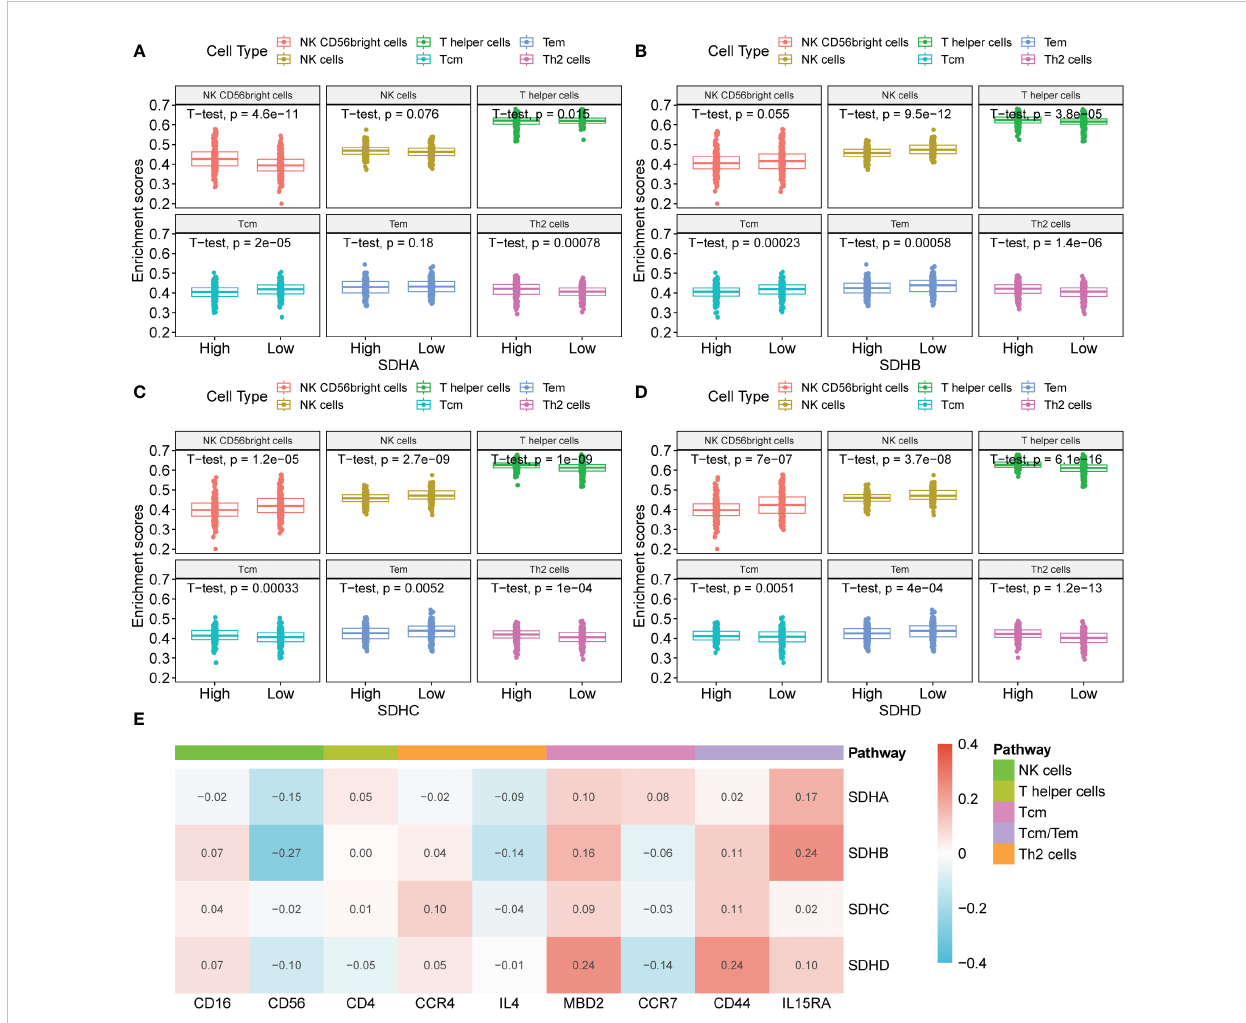
FIGURE 6 Association between SDHs and immune in fi ltration. (A-D) The ssGSEA analysis based on SDH factor expression for COAD and different types of immune cells. (E) The correlations between the SDHs expression and the expressions of mark genes of immune